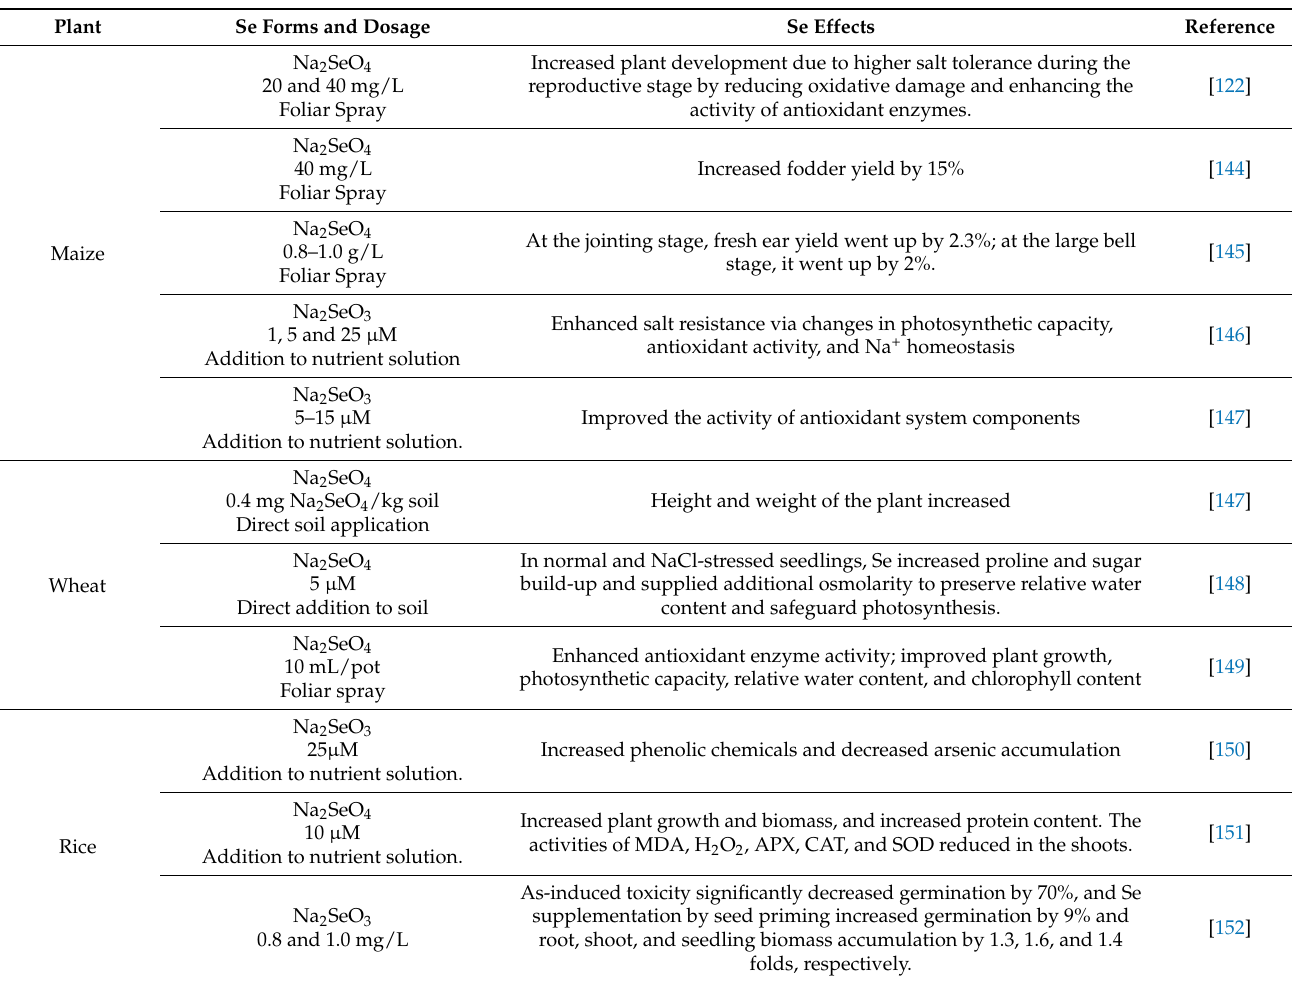
Table 1. Se biofortification effects in